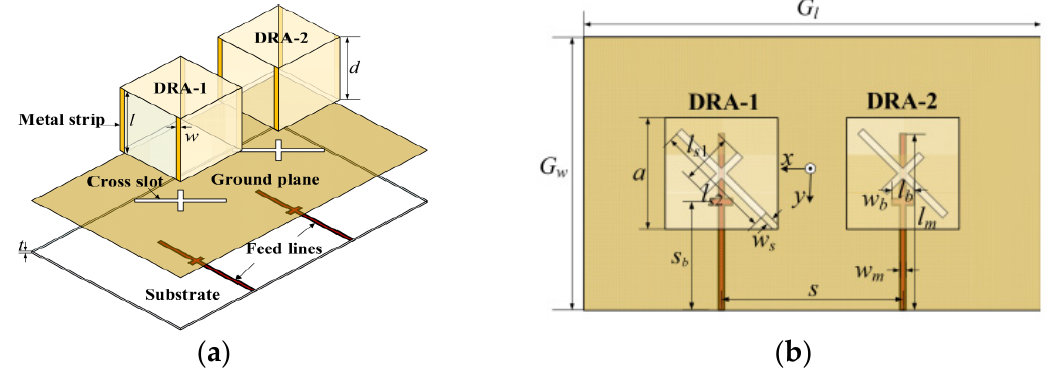
Figure 16. Configuration of the proposed MIMO DRA: ( a ) perspective view; ( b ) top view [67]. Another method that can lessen mutual coupling is orthogonally polarized [68,69].